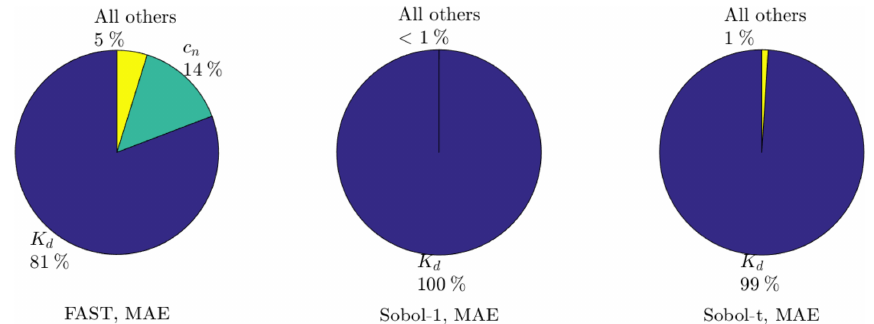
Figure 7. First- and total-order effects indicating the sensitivity of the model parameters on model performance. First-order effects account for parameters independently whereas second-order effects take include possible correlations between parameters. First-order effects were computed with the FAST and Sobol-1 methods. Second-order effects were computed using the Sobol- t method. The mean absolute error was used to evaluate the model.